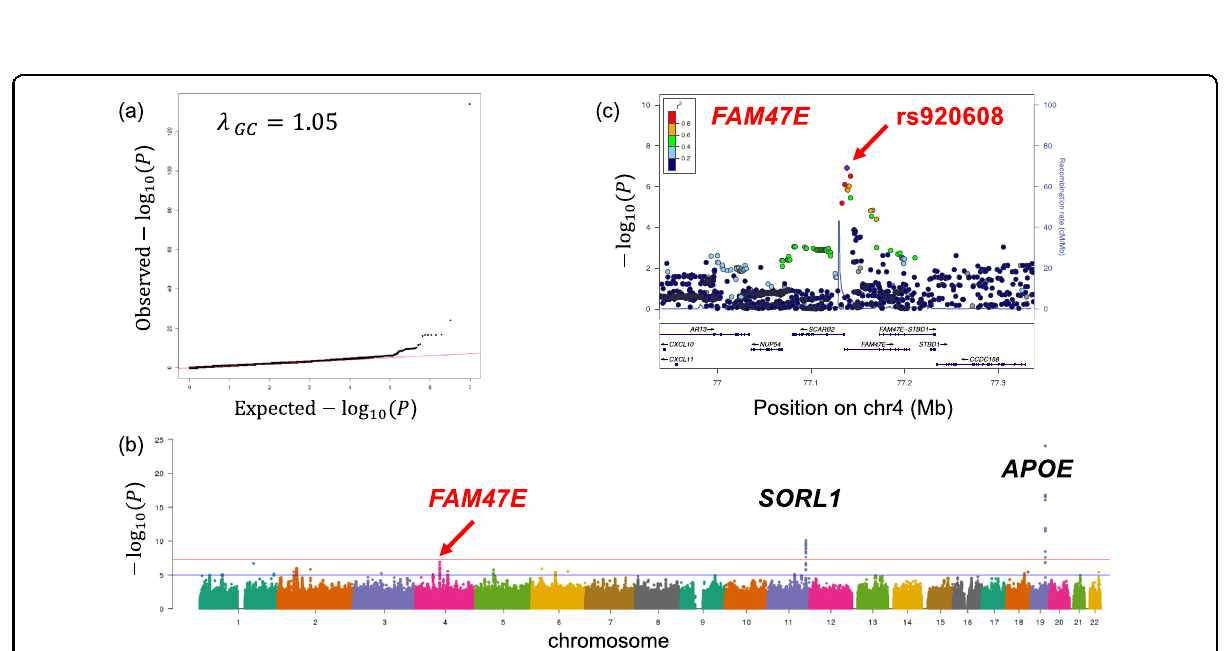
Fig. 2 Genome-wide association study (GWAS) of AD in the Japanese population. a Quantile-quantile plots of the genome-wide P values, b A Manhattan plot of the GWAS, and c Regional association plot of the variants in the FAM47E